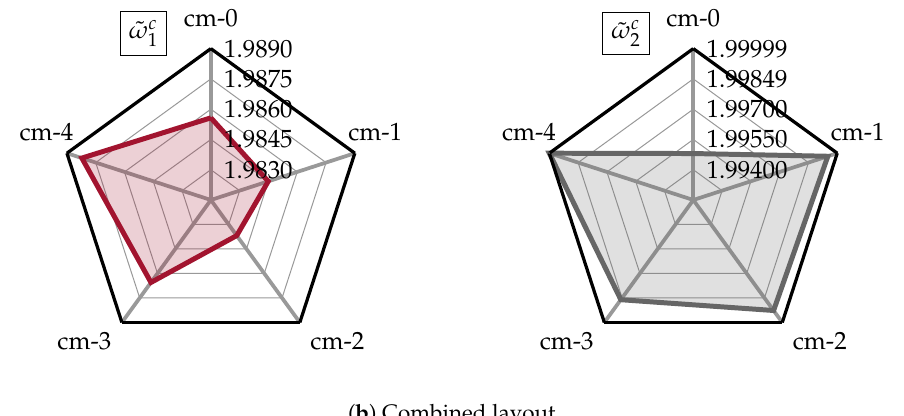
Figure 18. Accuracy and stability range comparison for all collision models with cell-centered and combined